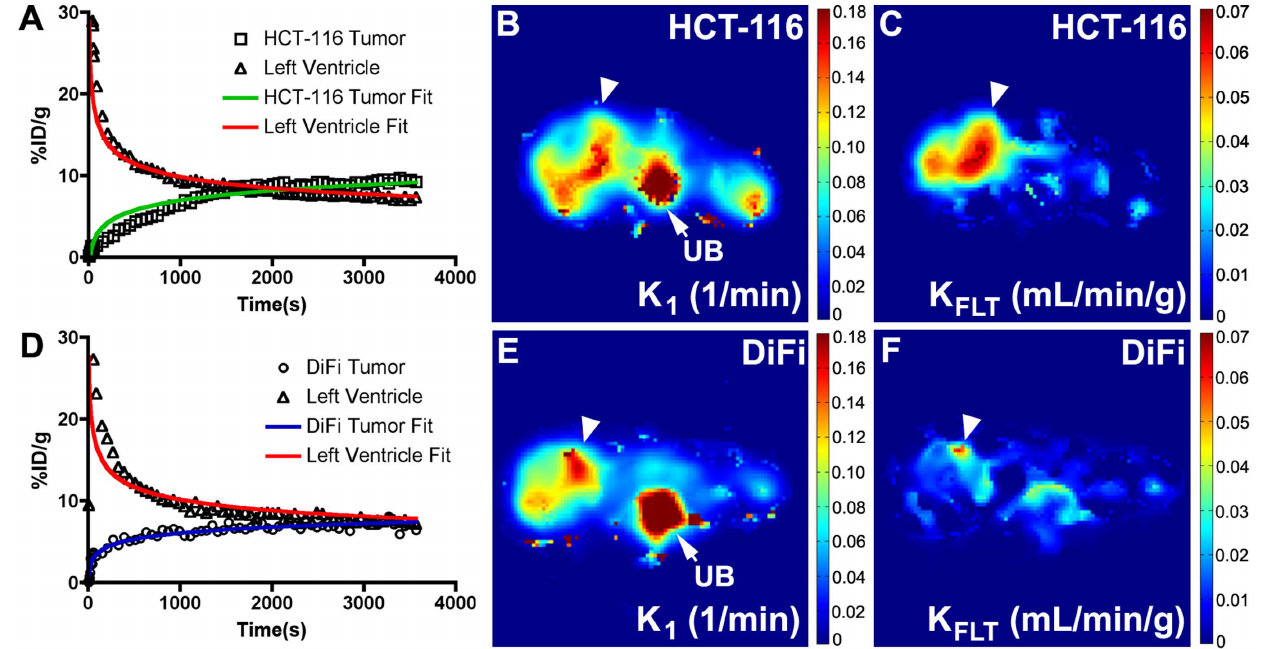
Figure 3. HCT-116 xenografts exhibit higher [ 18 F]-FLT flux than DiFi xenografts. Representative time activity curves for HCT-116 (A) and DiFi (D) xenografts and left ventricle estimates of blood pool activity are shown. In both models, a sharp rise in activity in the blood pool is observed following tracer injection, followed by rapid clearance. Fit lines derived from compartmental modeling closely matched the measured data. Parametric maps reveal heterogeneous intratumoral delivery of [ 18 F]-FLT in both HCT-116 (B) and DiFi (E) xenografts (tumor localized by arrowhead). Increased [ 18 F]-FLT delivery was observed in the urinary bladder (denoted by UB) in both cell line xenografts. The tumor regions exhibiting the greatest [ 18 F]-FLT flux in HCT-116 tumors (C) also exhibited the highest tracer delivery. Only modest [ 18 F]-FLT flux was observed in DiFi xenografts (F), despite having similar delivery as HCT-116 xenografts (B).